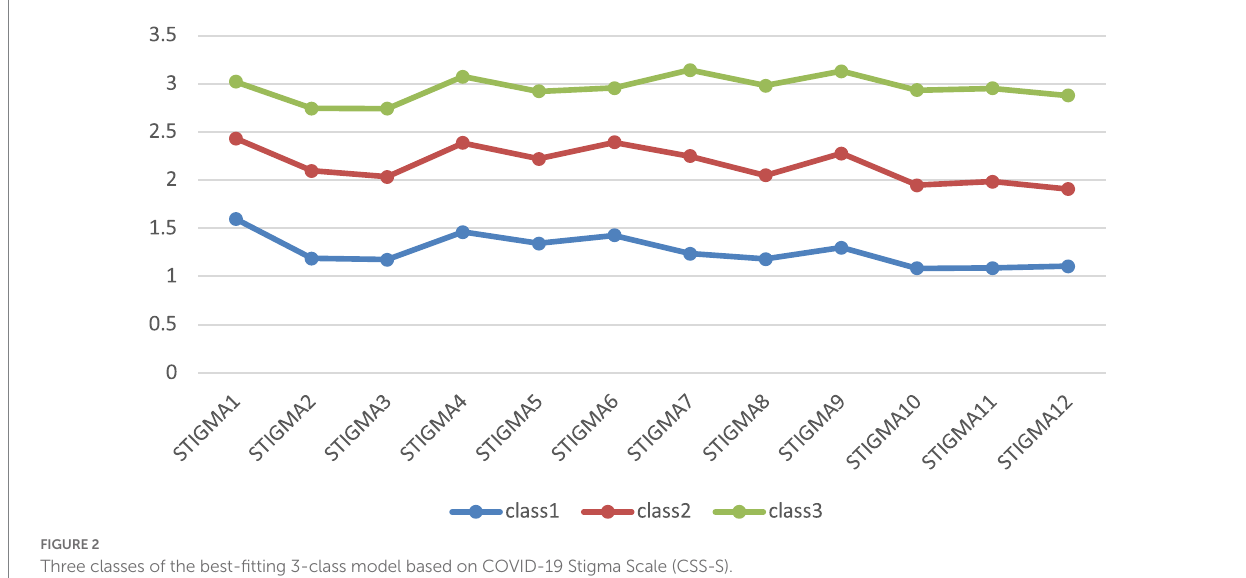
FIGURE 2 Three classes of the best-fitting 3-class model based on COVID-19 Stigma Scale (CSS-S).